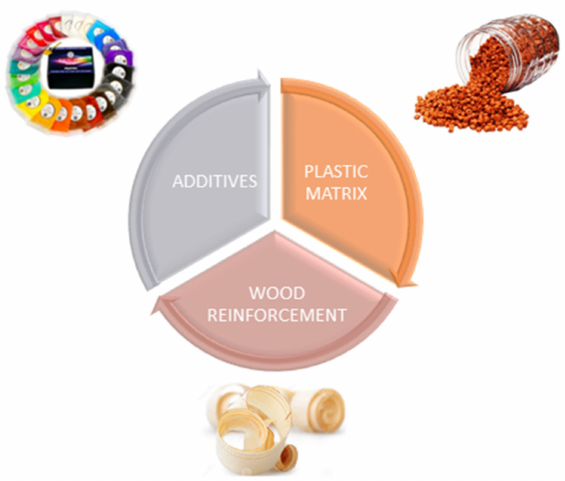
Figure 1. Wood-filled plastic components [31–33].